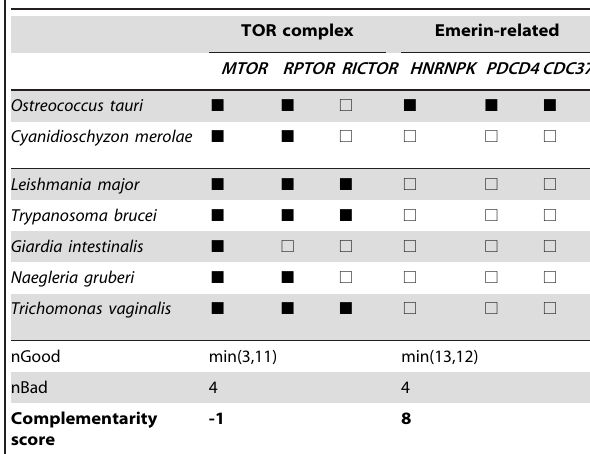
Table 2. Examples of triplet profiles. Table 2. Cont.